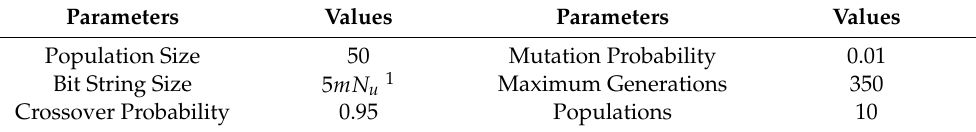
Table 3. Parameters choices of genetic